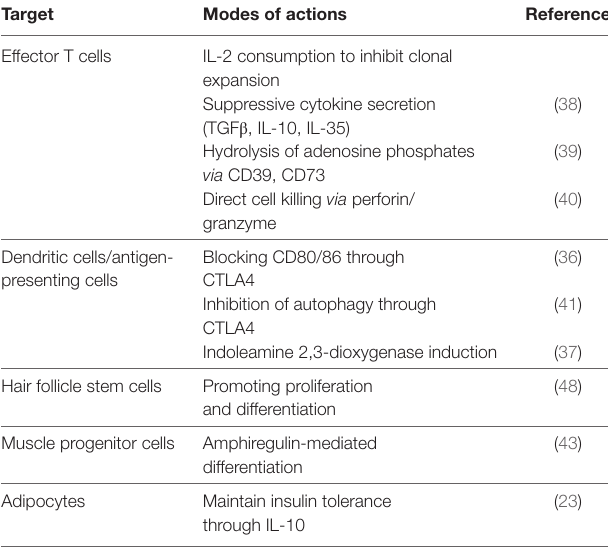
TabLe 2 | Modes of action of